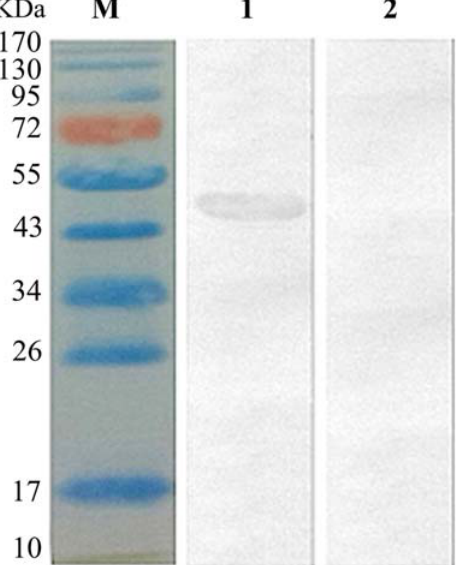
Figure 2. Western blotting of the expression of HSP40 protein encoded by the plasmid pVAX1-HSP40 in vitro . One band of approximately 46 kDa was detected in the pVAX1-HSP40-trans- fected cells (Lane 1), whereas no band was detected in protein extract of cells transfected with the pVAX1 control (Lane 2). M: protein marker.